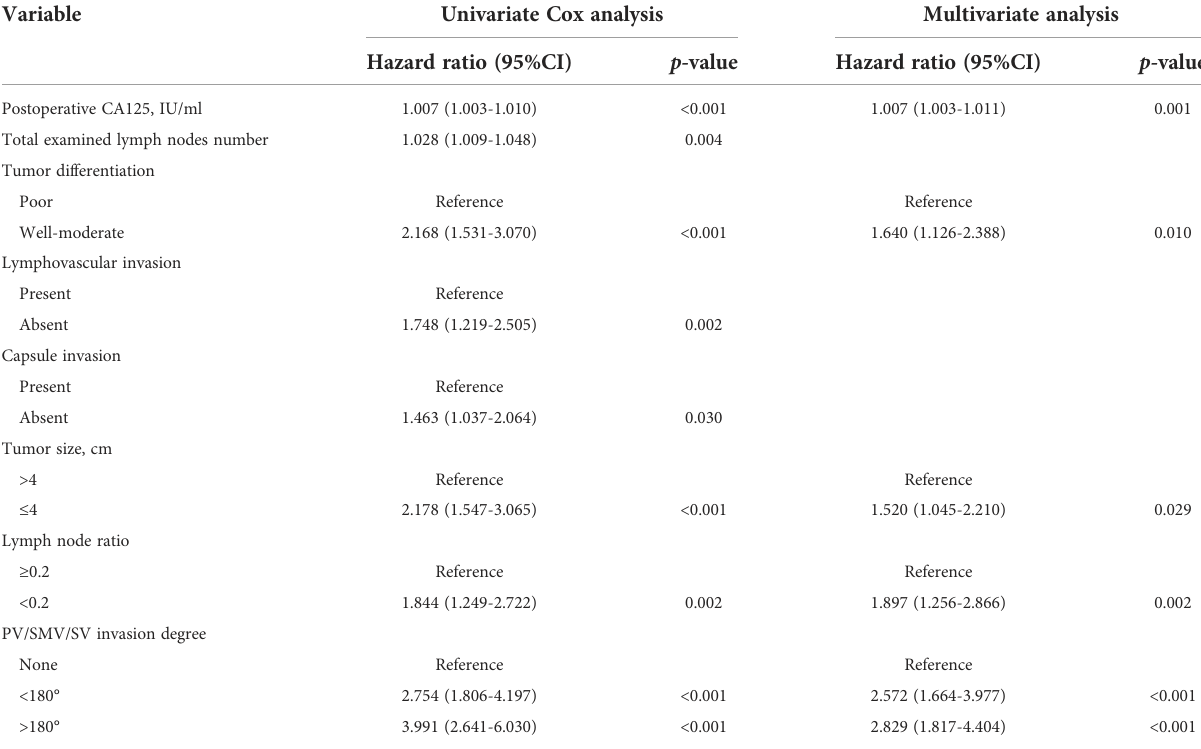
TABLE 3 Univariate and multivariate analysis of predictive factors for liver metastasis in the training cohort.